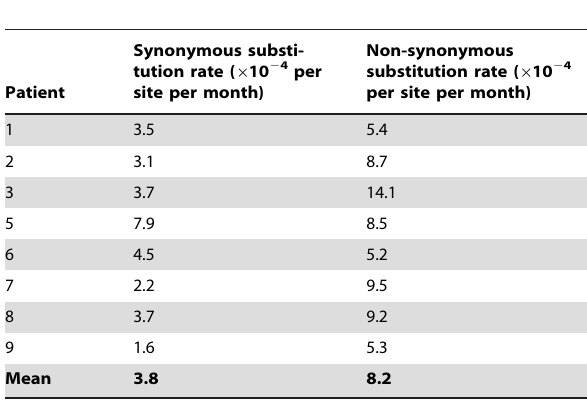
Table 2. Estimates of synonymous and non-synonymous substitution